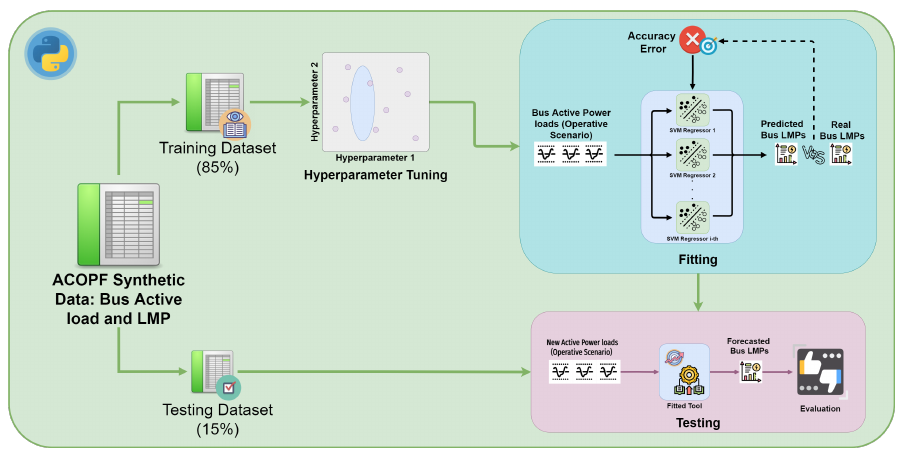
Figure 4. Tool development